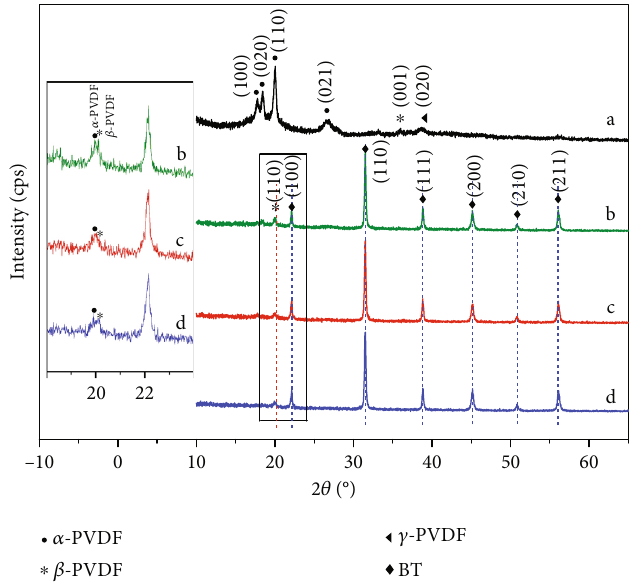
Figure 1: XRD patterns of PVDF (a), BT10/PVDF (b), BT15/PVDF (c), and BT20/PVDF